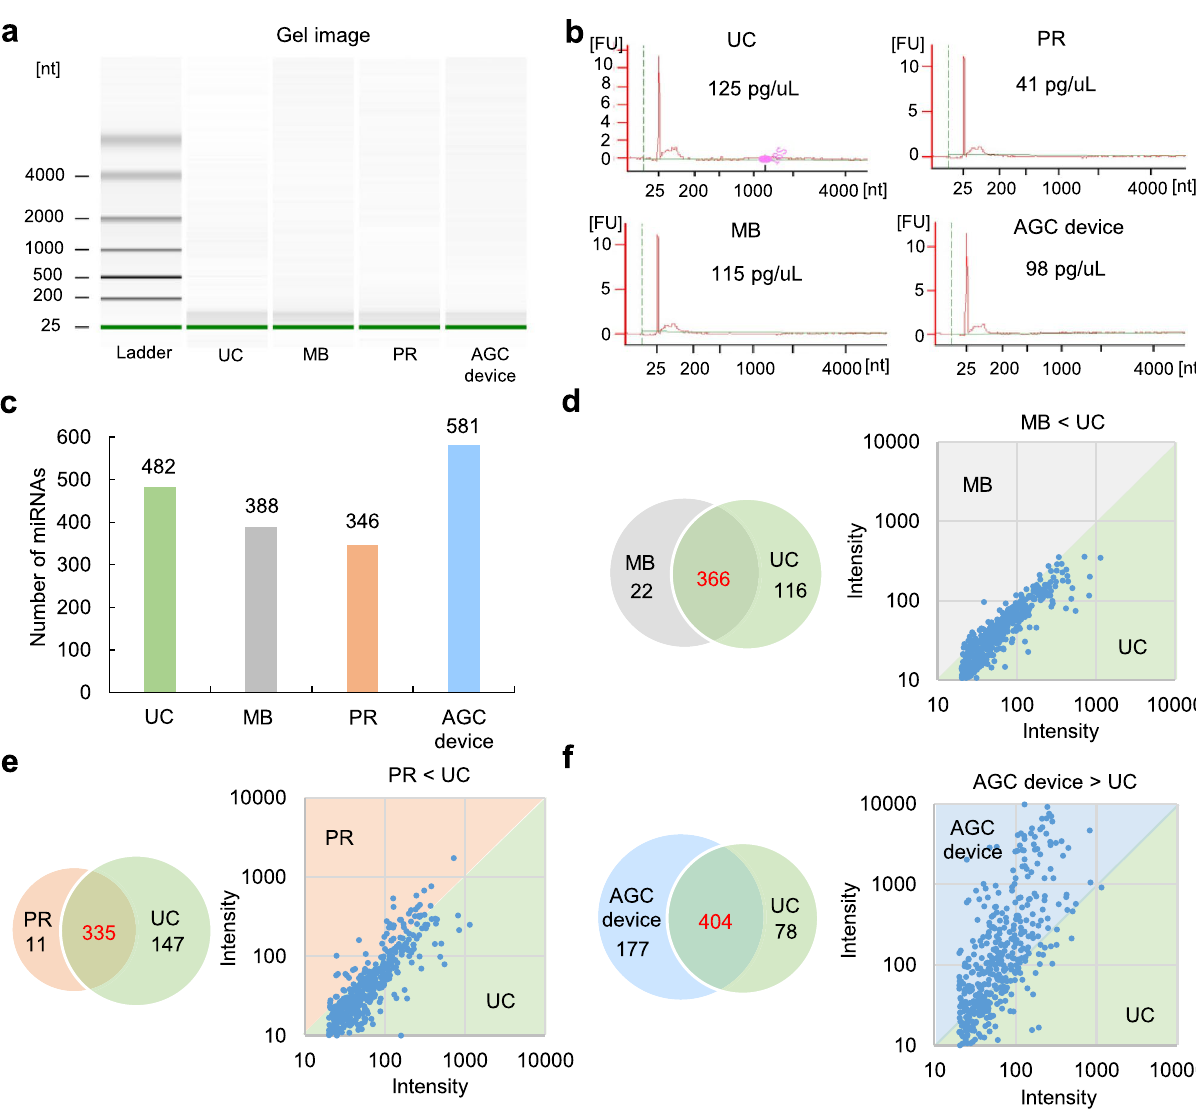
device was 600 nm, because the capture rate of HepG2-EVs was > 90% and the time required for centrifugation for the AGC device was shorter than 5 min. In contrast, when MPG membranes with a pore size smaller than 600 nm were used, it took more than 30 min to complete the centrifugation of the AGC device. In addition, when the MPG membranes with a smaller pore size were used, the centrifugation of serum samples was not completed, even after more than 1 h. Thus, we used an MPG membrane with a pore-size of 600 nm and a thick- ness of 1.0 mm in the AGC device. Of course, the pore-size of the MPG membrane can be adjusted to the size of different types of EVs. In this study, EVs smaller than 600 nm derived from cell culture supernatant, serum and urine were captured with an MPG membrane with a pore size of 600 nm of pore-size. This finding is considered to be dependent on the physical adsorption due to the stable macro-porous co-continuous structure formed by spinodal decomposi- tion in the MPG membrane. This effect is explained by the “Ferry-Renkin equation” proposed by P. J. Ferry and E.M. Renkin. The Ferry-Renkin equation shows that smaller size of solutes than pore size of microporous micro- filtration membranes cannot completely pass through the membrane and are captured in the membranes 35–38 . The capture rate of EVs was therefore assumed to be influenced by the size of the macro-pores, the thickness of